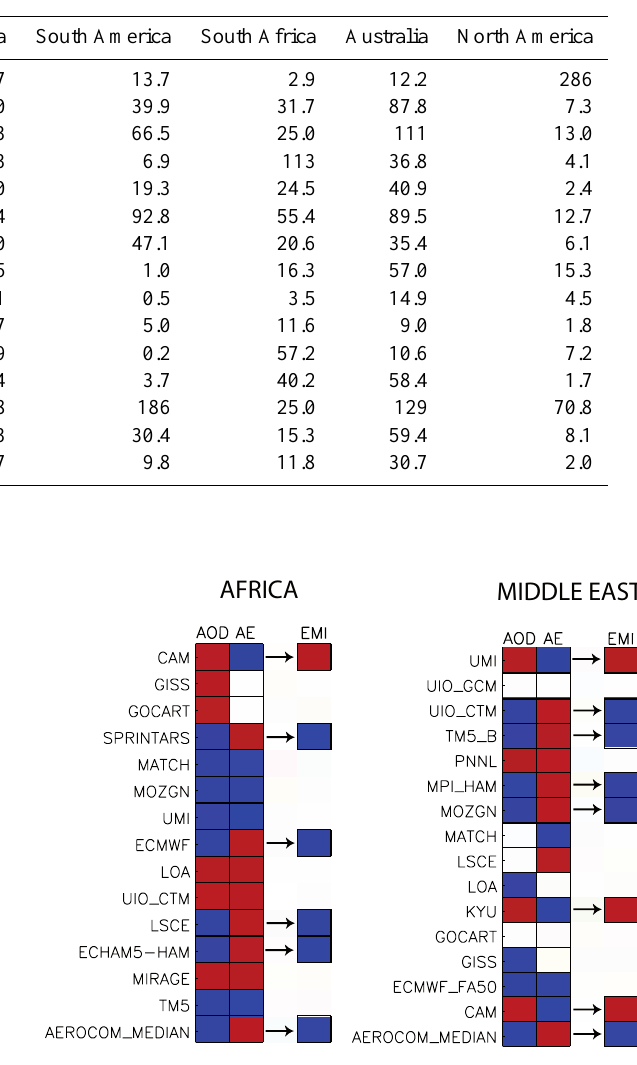
Table 5. Yearly emission fluxes [Tgyr − 1 ] for regions illustrated in Fig. 2. Fluxes being overestimated are highlighted in red and those underestimating are highlighted in blue. Models have been grouped according to their size ranges; models GISS to UMI simulate dust aerosols in the size range 0.1–10µm, models ECMWF and LOA in the size range 0.03–20µm and UIO CTM in the range 0.05–25µm. Models LSCE, TM5, ECHAM5-HAM and MIRAGE describe dust aerosols through 1, 2, 2 and 4 modes respectively. For mass mean radius and standard deviation of each mode see Table 1.